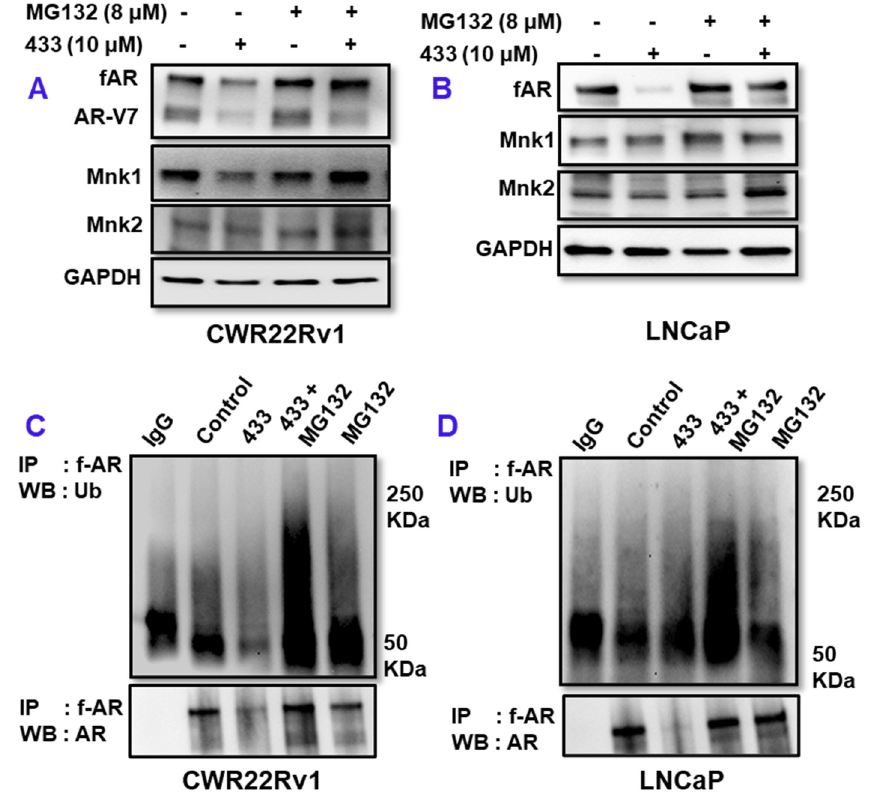
Figure 2. VNPP433-3 β enhances ubiquitin-dependent proteasomal degradation of f-AR and AR-V7. ( A , B ) Androgen deprived CWR22Rv1 and LNCaP cells were treated with DMSO or VNPP433-3 β for 4 h. Cells were then incubated in presence or absence of MG132 (8 µM) for 8 h and immunoblotted for AR, AR-V7, Mnk1 and Mnk2. GAPDH served as loading control. ( C , D ) 22Rv1 and LNCaP cells were treated as in ( A , B ) and 1 mg of total cell lysate was used for immunoprecipitation and the blots were probed with ubiquitin antibody. The uncropped blots are shown in Figure S2.